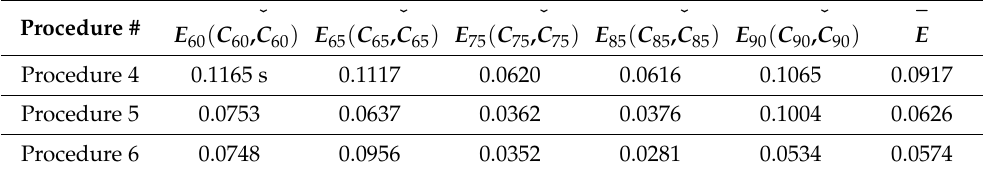
and ˇ C sp (procedures 4, 5, and 6). 1 1